Question: Looking at the figure, what chart type is it?
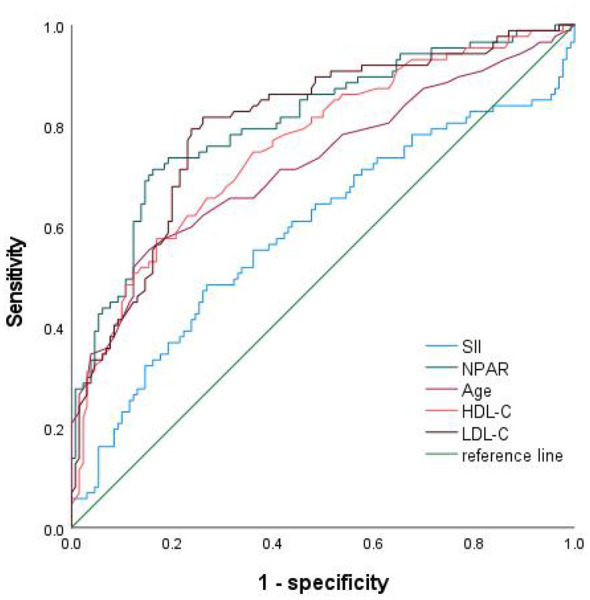
Answer: line